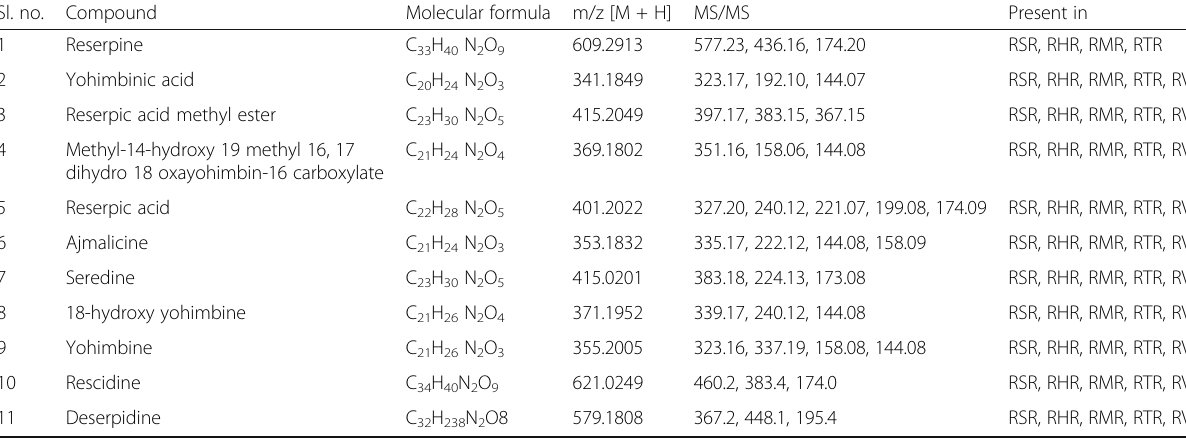
Table 5 LC/MS-MS analysis of alkaloid fractions of various Rauvolfia species Sl. no.